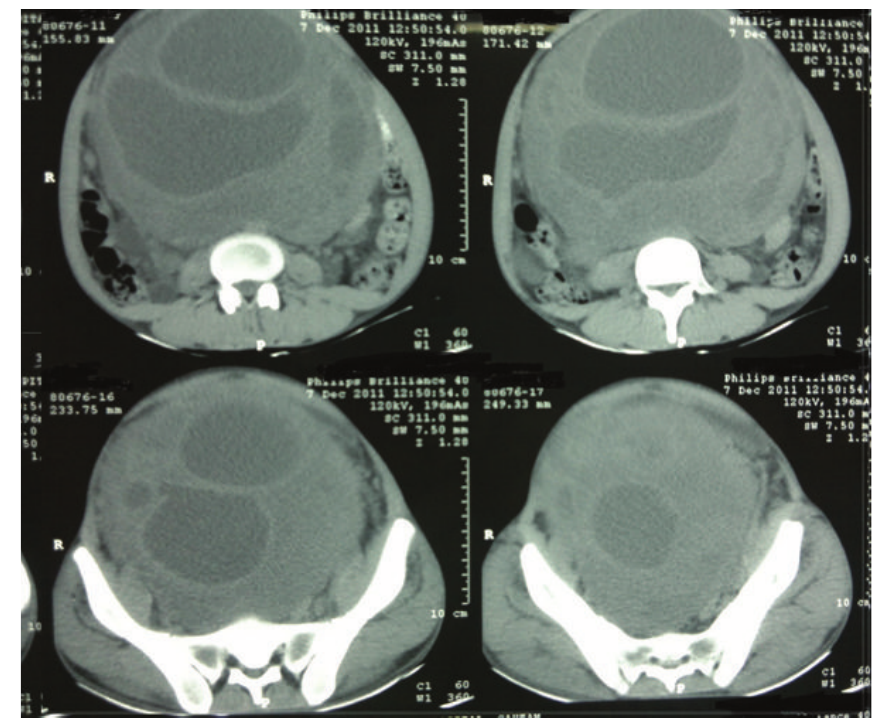
Figure 2: CECT showing large solid-cystic mass arising from sacrococcygeal